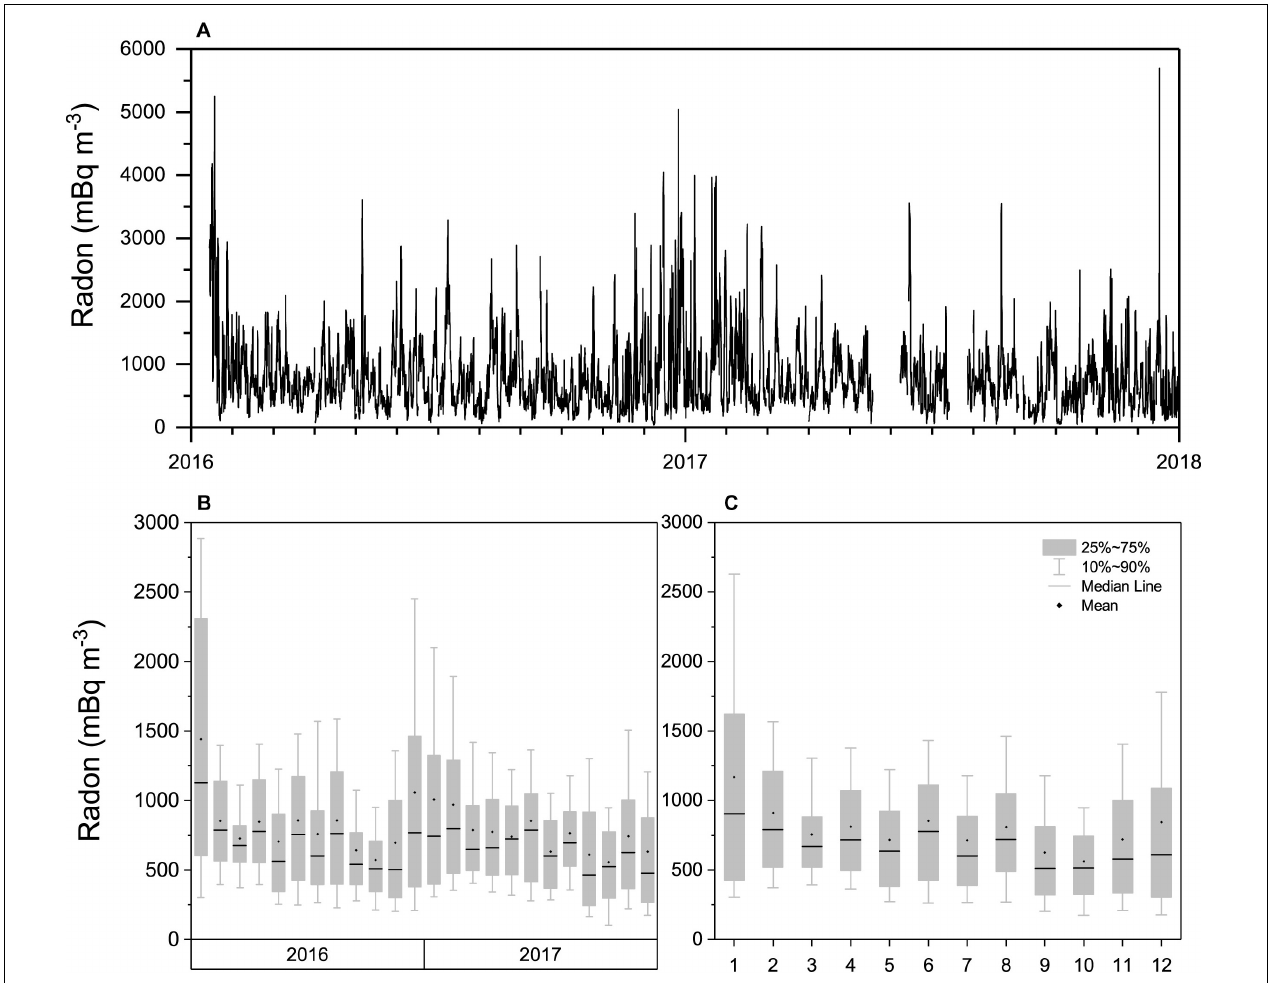
FIGURE 13 | (A) Hourly, and (B,C) monthly distributions of JBS radon concentrations for 2016 and 2017. Refer to key for distribution box-plot details.